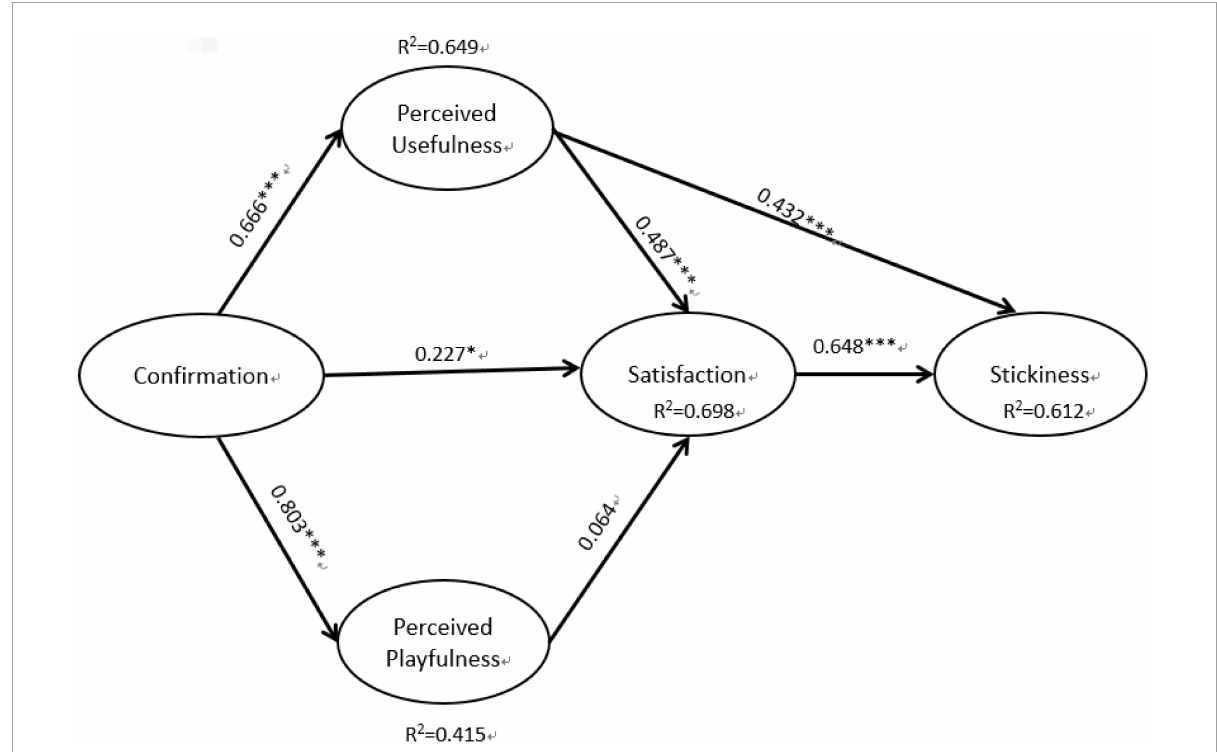
FIGURE2 Partial least squares (PLS) results of the research model. ∗ P < 0.05; ∗∗ P < 0.01; ∗∗∗ P <